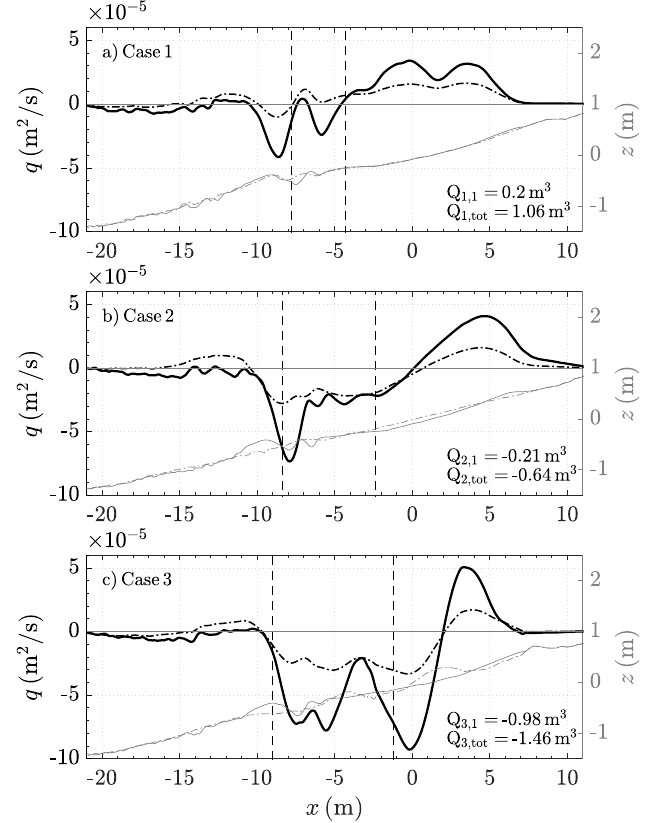
Figure 6. Left ordinate: Sediment transport rate q during the first run (first 30min) (solid black line) and during the entire duration of E2 (120min) (dashed-dotted black line). Values of the bulk sediment transport Q are given for the first run (index ‘1’) and for the total duration of condition E2 (index ‘tot’). Vertical dashed lines mark the breaking region during the first run. Right ordinate: initial and final profile of each case as dashed-dotted and solid grey lines, respectively. ( a ) Case1; ( b ) Case2; ( c )